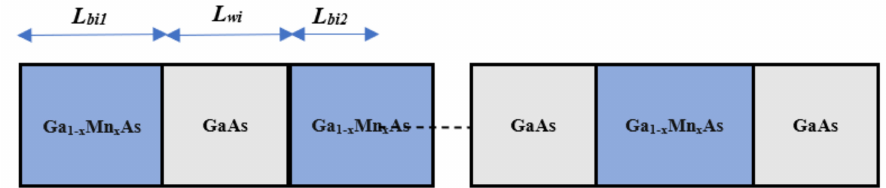
Figure 6. GaAs/Ga 1 − x Mn x As/GaAs asymmetric structure ( L b1i = 3 nm, L b2i = 1.5 nm, and L wi = 2.5 nm).